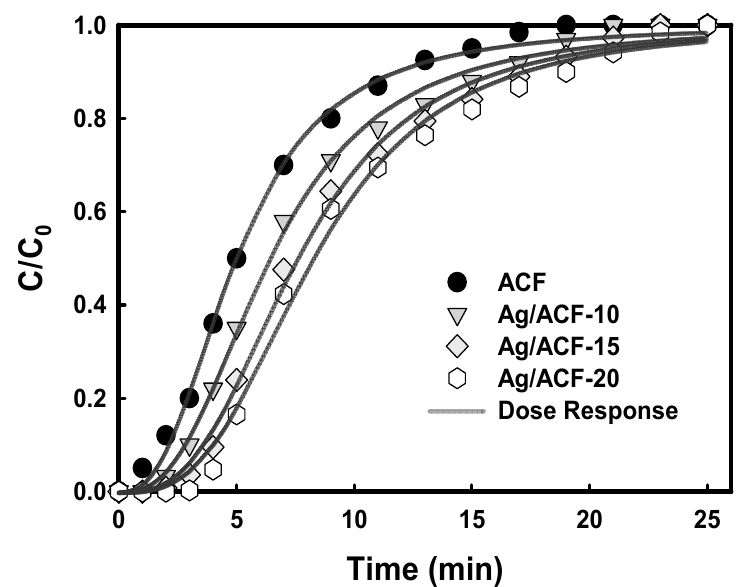
Figure 9 is a graph fitted by applying the Dose–Response model to the results of Figure 7, and satisfactorily fitting the experimental data showing the asymmetric shape of the AA adsorption breakthrough curve for ACF and Ag/ACF composites.